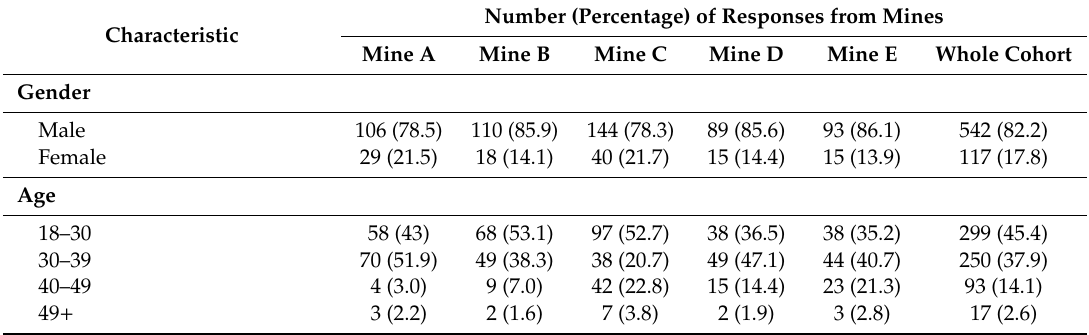
Table 2. Comparison across mines of the characteristics of the questionnaire survey participants.